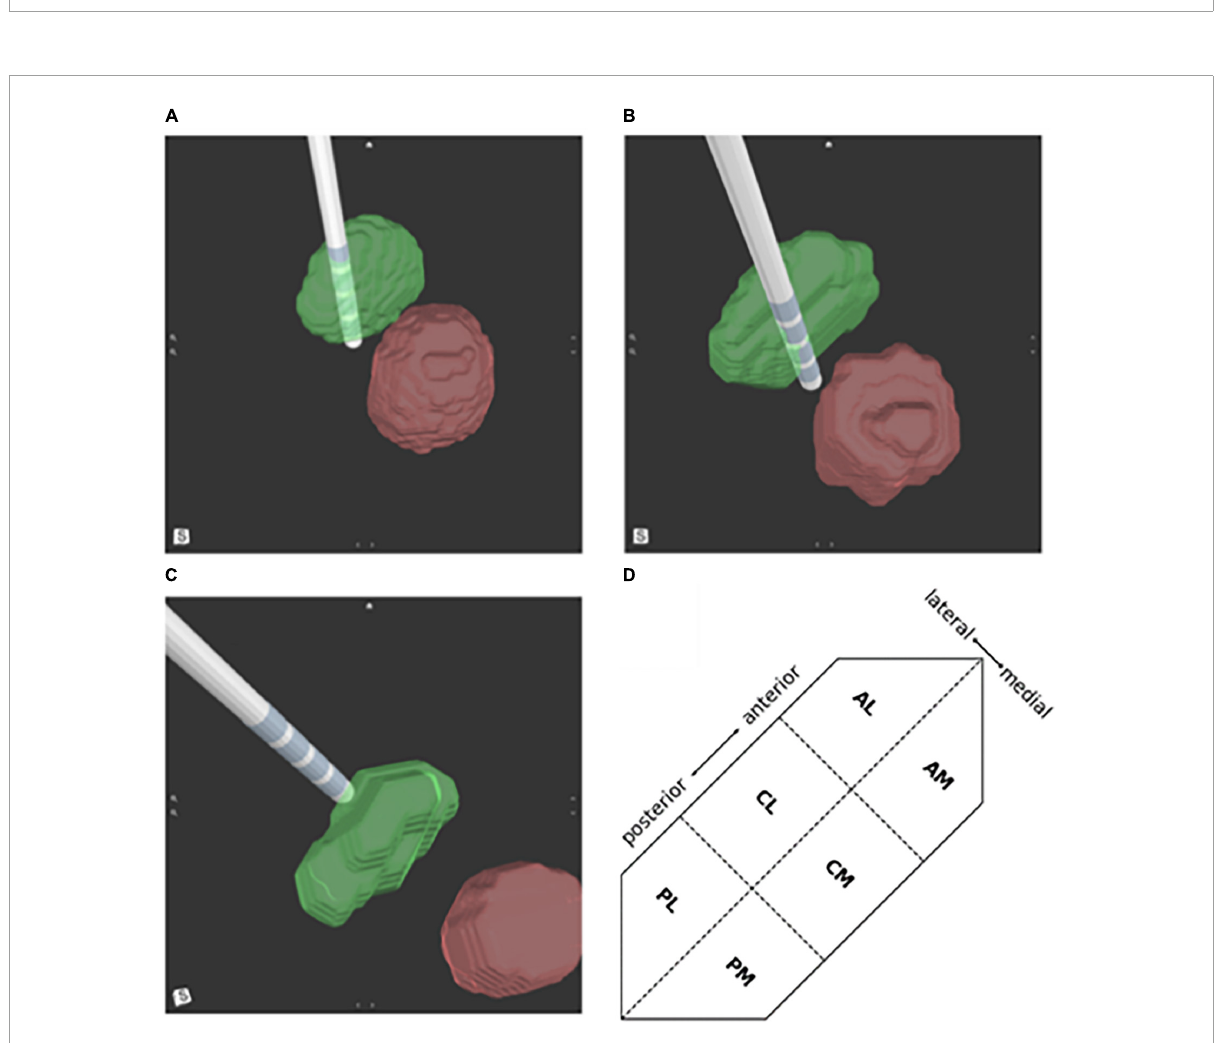
FIGURE2 Deep brain stimulation (DBS) lead location in respect to the subthalamic nucleus (STN) (green) and red nucleus (red). Activated lead contacts were evaluated for their position as (A) fully within the STN border, (B) partially inside the STN border, or (C) outside the STN. (D) A schematic illustration of a left STN showing division of the 6 regions; PL, posterolateral; PM, posteromedial; CL, centrolateral; CM, centromedial; AL, anterolateral; AM,